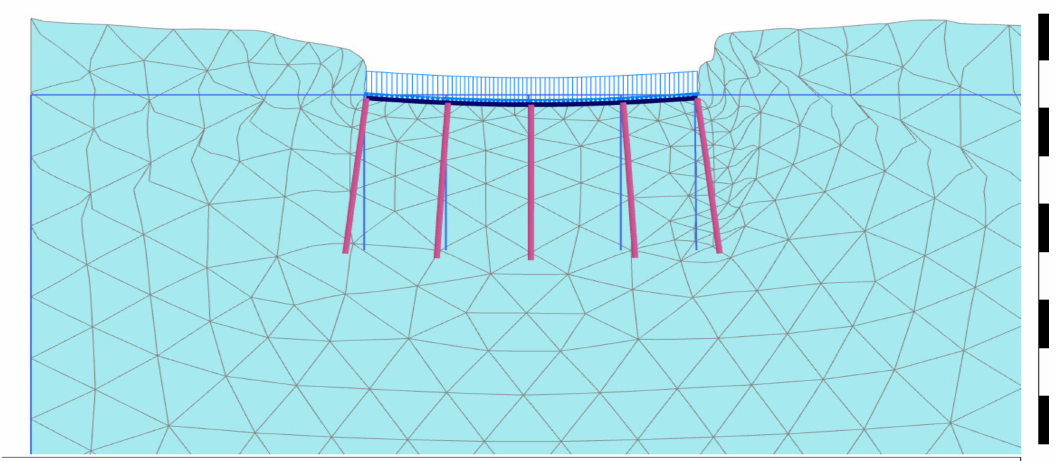
Figure 18. Effect of lateral swelling on piles